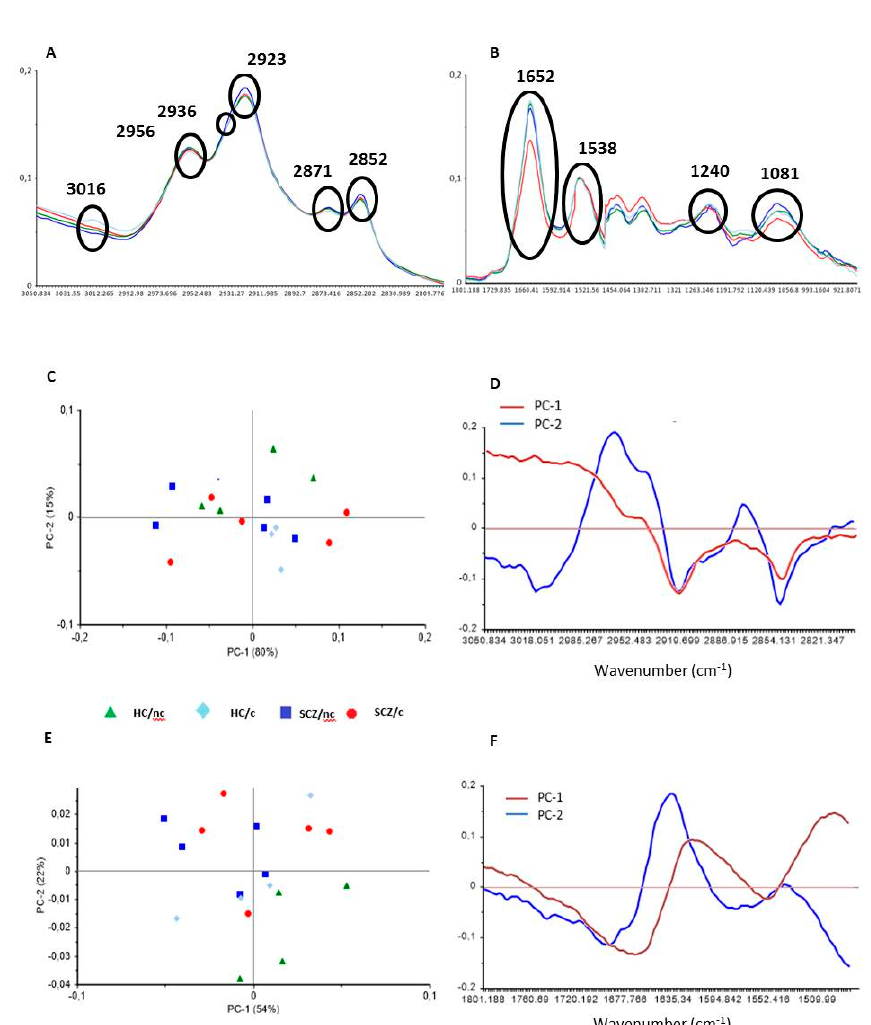
Figure 1. Mean FTIR of dried olfactory neuroepithelium (ON) cells from healthy controls non-cannabis users (HC/nc, green); healthy controls cannabis users (HC/c, light blue); schizophrenic patients non-cannabis users (SCZ/nc, dark blue) and schizophrenic patients cannabis users (SCZ/c, red). The main peaks are assigned for ( A ) the lipid region (3050–2800 cm − 1 ), and ( B ) the protein fingerprint region (1800–900 cm − 1 ). Contribution of the first two components in the principal component analysis (PCA) for lipids (3050–2800 cm − 1 ) ( C , D ), and for proteins (1800–1480 cm − 1 ) ( E , F ). In C, and E, symbols represent the mean values for each subject.